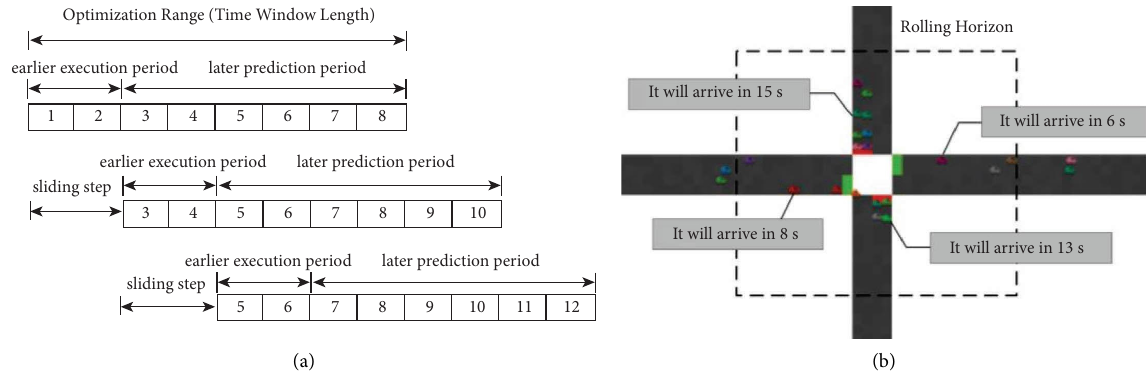
Figure 5: Te optimization principle and the interface of the rolling horizon: (a) rolling horizon optimization principle and (b) the interface of rolling